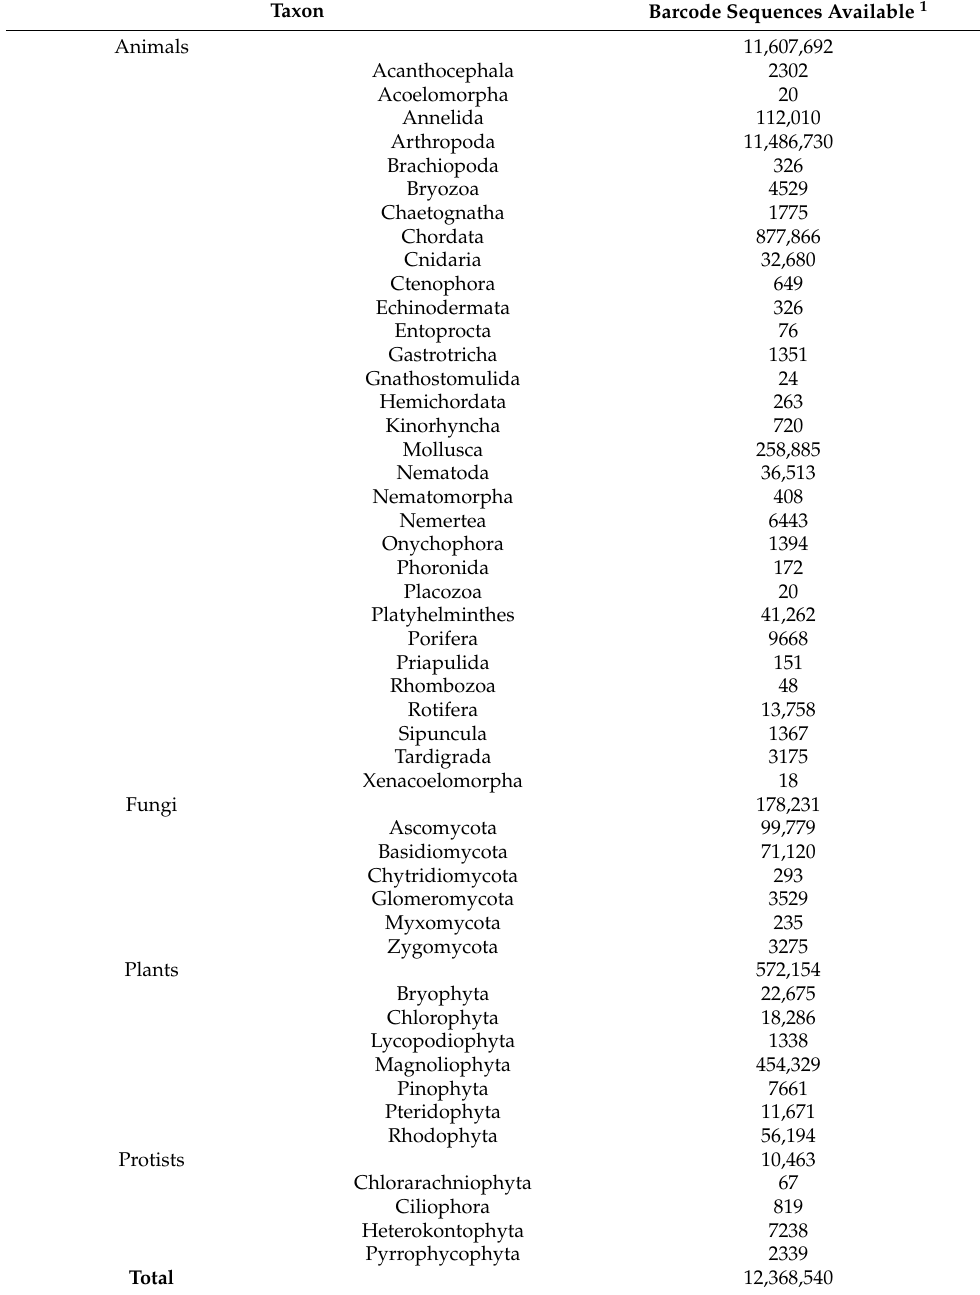
Table 1. Diversity and number of barcode sequences available in the Barcode of Life Data System (BOLD) database, taxon labels follow the BOLD format.